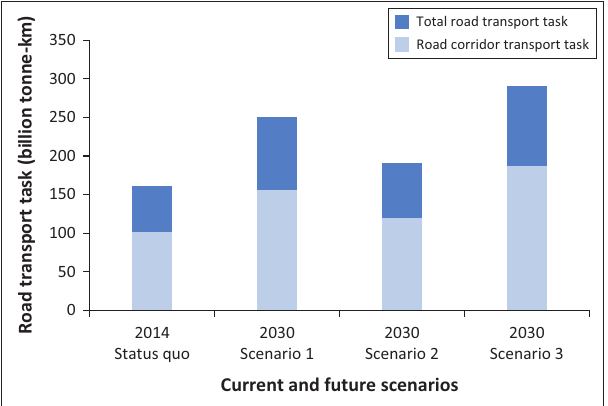
FIGURE 3: South Africa’s current and projected road freight transport task in